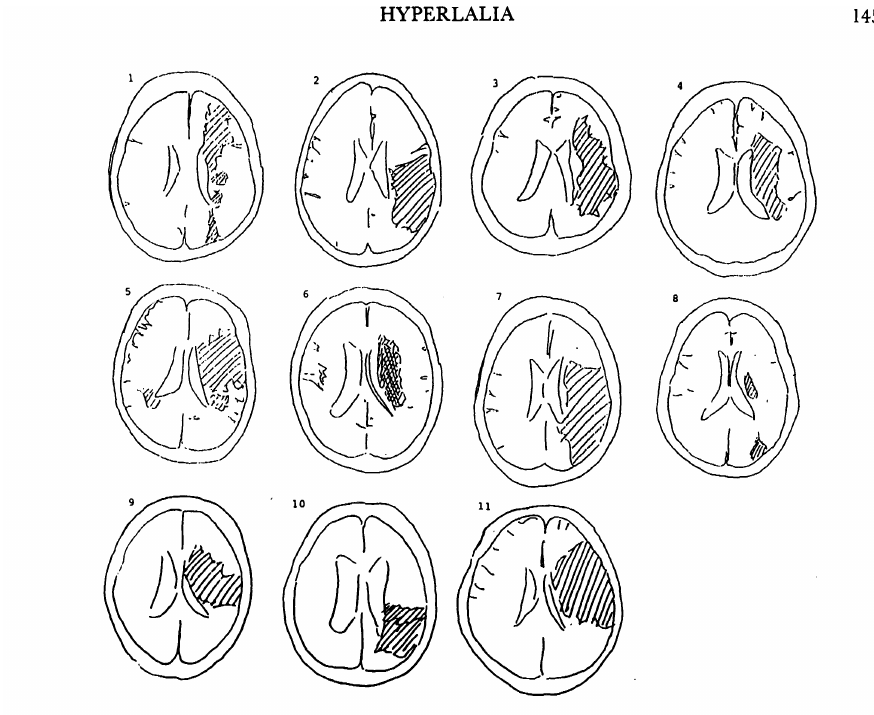
FIG. I. Schematic representation of CT lesions in all the cases of hyperlalia at approxi mately the same level just above the basal ganglia. Number represents case number as summarized in Table